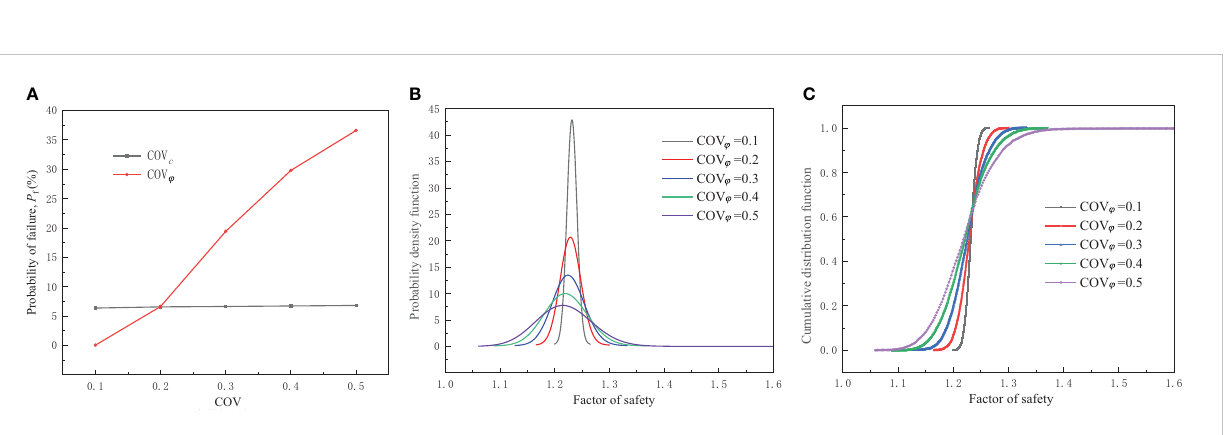
FIGURE 10 The effect of the COV: (A) In fl uence of different COV on failure probability; (B) probability density function; (C) probability distribution of the FOS.